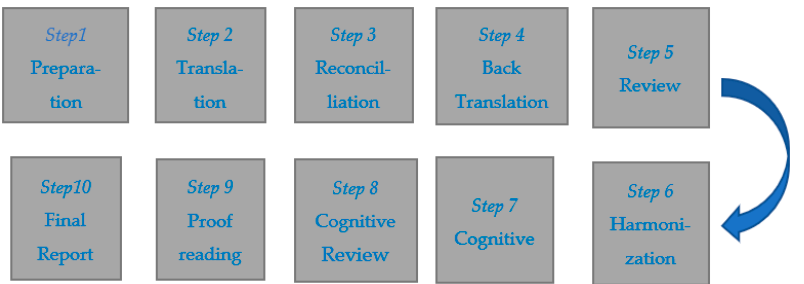
Figure 1. Steps involved in the translation and cross-cultural adaptation process of the MBC. Table 1. Detailed description of the translation and cross-cultural adaptation process of the MBC. Steps